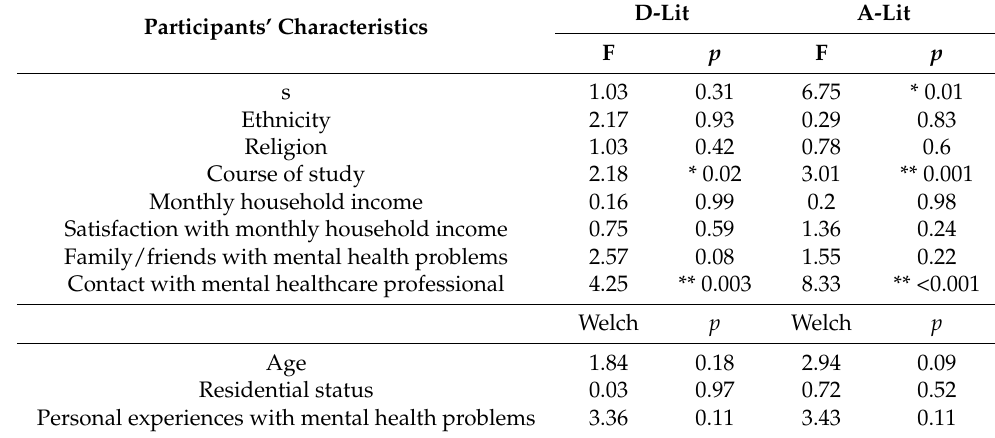
Table 4. Relationship between participants’ characteristics and depression and anxiety literacy